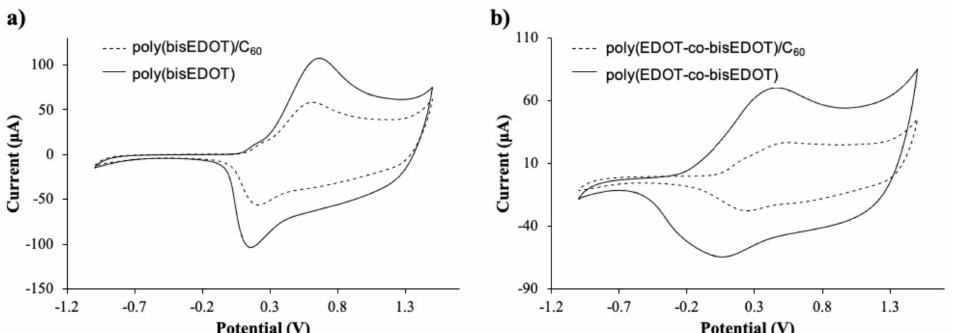
Figure 3. Cyclic voltammograms of the films, 2nd scan of ( a ) bisP and ( b ) PbisP electropolymerized in presence of C 60 (dotted line) and Tetrabutylammonium hexafluorophosphate (TBAPF 6 ) (dark line).